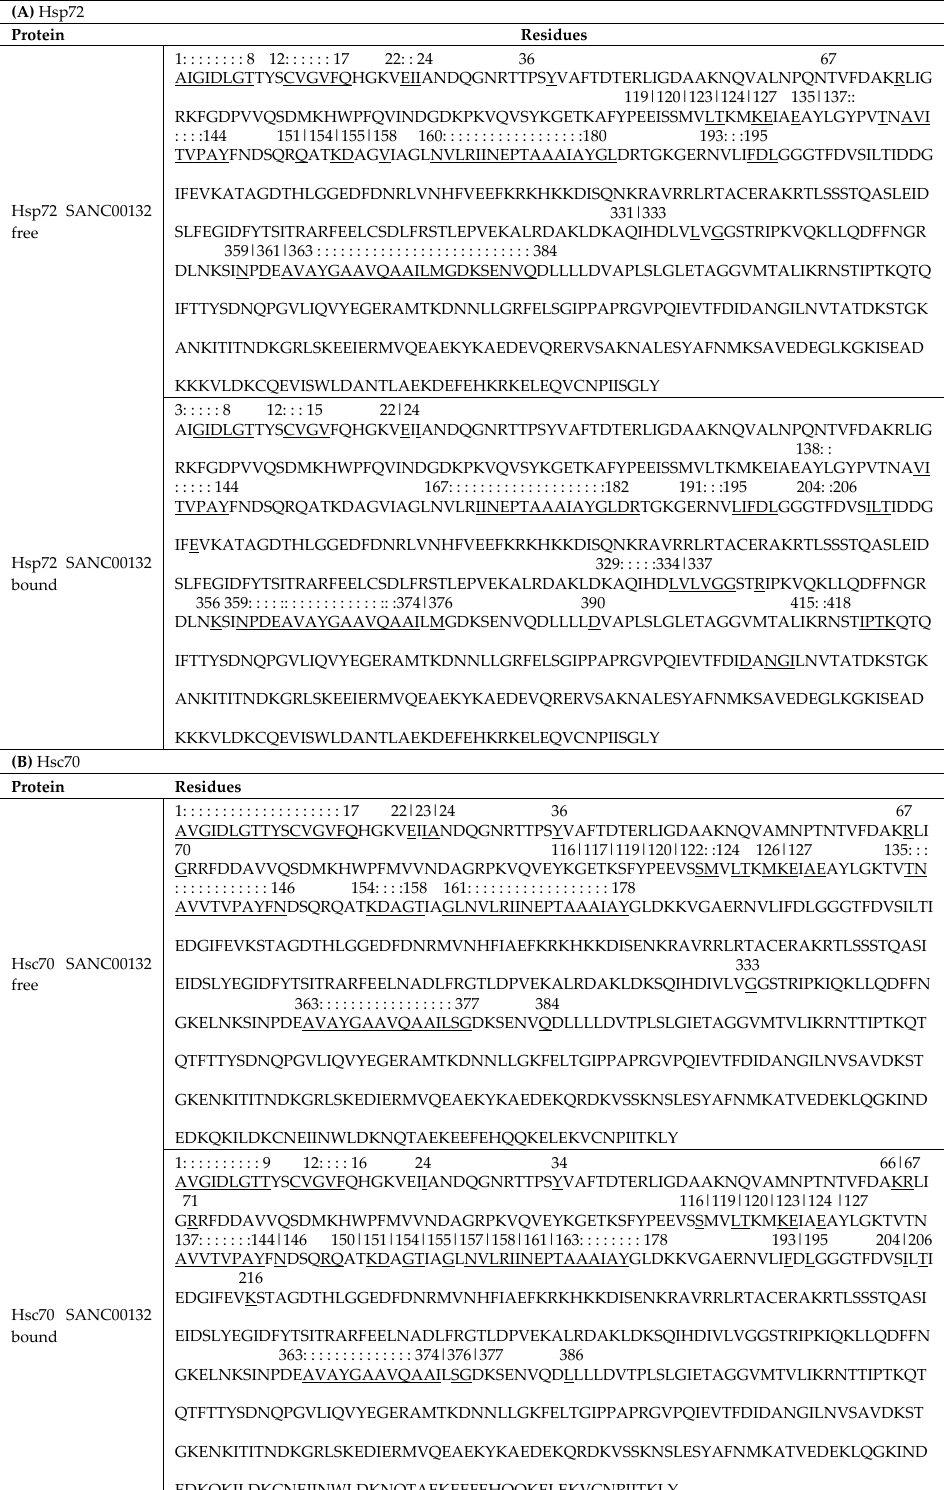
Table 2. ( A and B ) Tabulated summary of amino-acids that yielded low average L values averaged across all ligand-free and ligand-bound simulation systems of each protein. Identified residues and respective positions were mapped within the primary sequence. Residues are underlined while positions are indicated above the residues. Continuous stretches of residue positions are indicated by colon punctuations. Residue numbering is according to E. coli DnaK sequence (UniProtKB ID: P0A6Y8). Equivalent residue numbering from complete Hsp72 and Hsc70 sequences are tabulated in Table S8A,B. Molecules 2018 , 23 , x FOR PEER REVIEW 14 of 31 (A) Hsp72 Protein Residues